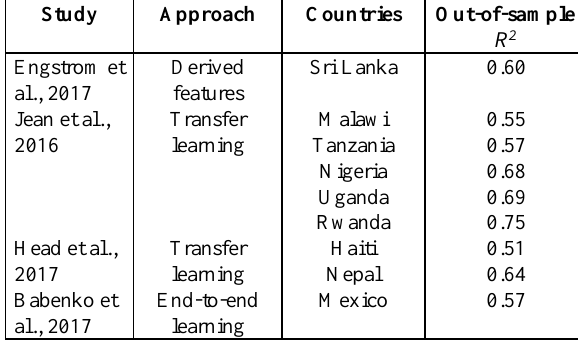
Table 1. A summary of the out-of-sample R 2 results of past studies on poverty prediction using remote sensing